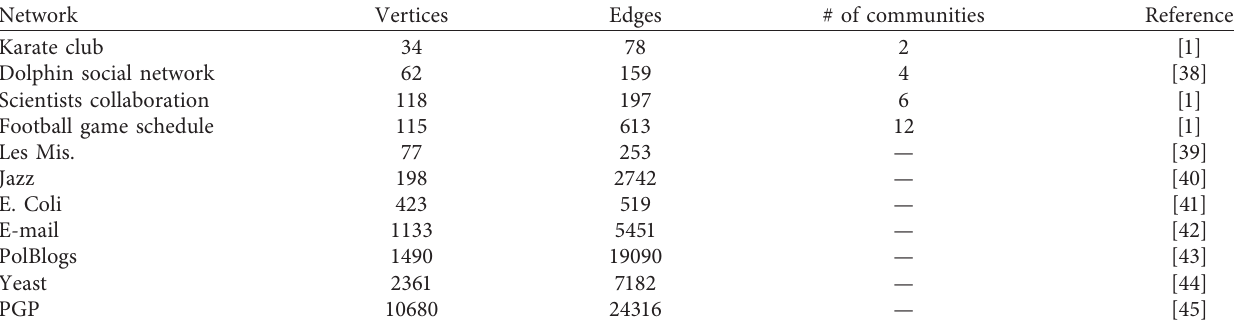
Table 2: The details of the 11 real-world networks used in our experiments.